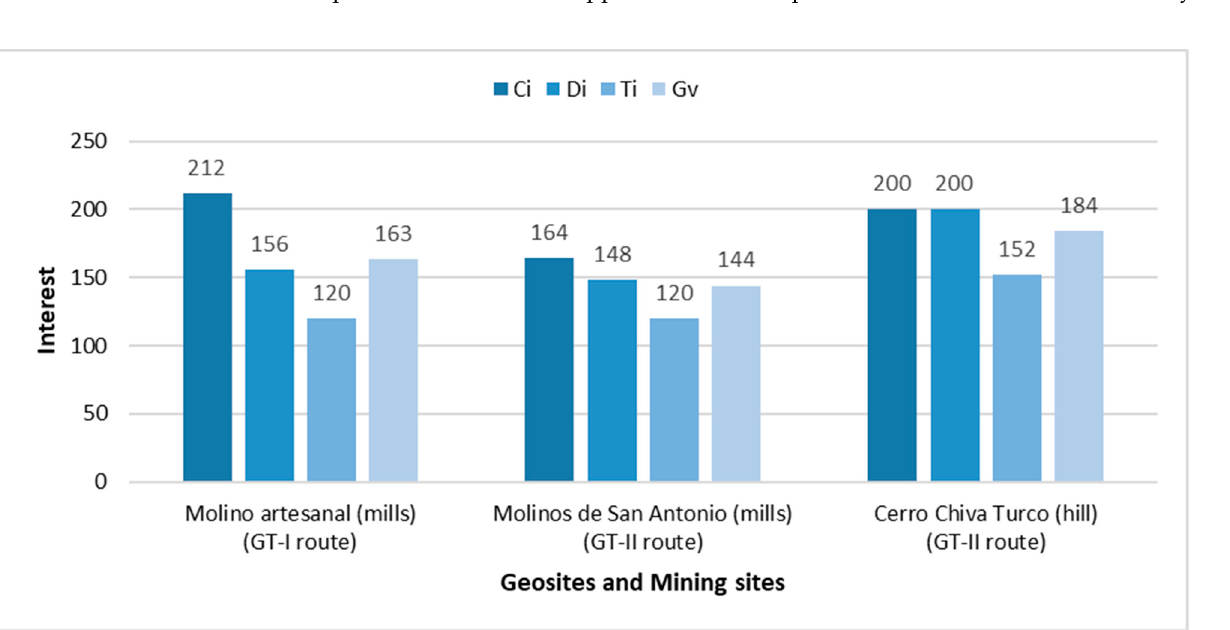
Figure 5. Assessment of pending geosites and mining sites that make up routes GT-I and GT-II.